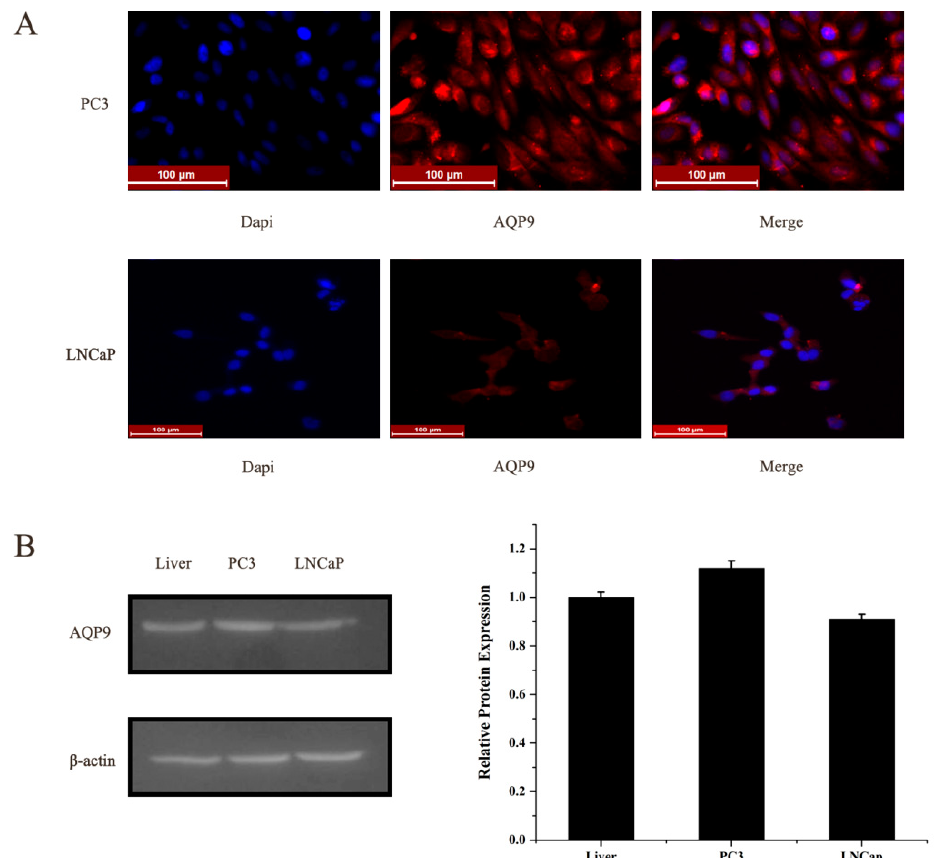
Figure 1. ( A ) Expression of AQP9 in PC3 and LNCap cells was analyzed by immunofluorescence; ( B ) expression of AQP9 in PC3 and LNCap cells was determined by Western blot. The mean of AQP9/ β -actin expression in liver set as 1.0. Data were based on three independent experiments, and shown as mean ± SD (standard deviation).